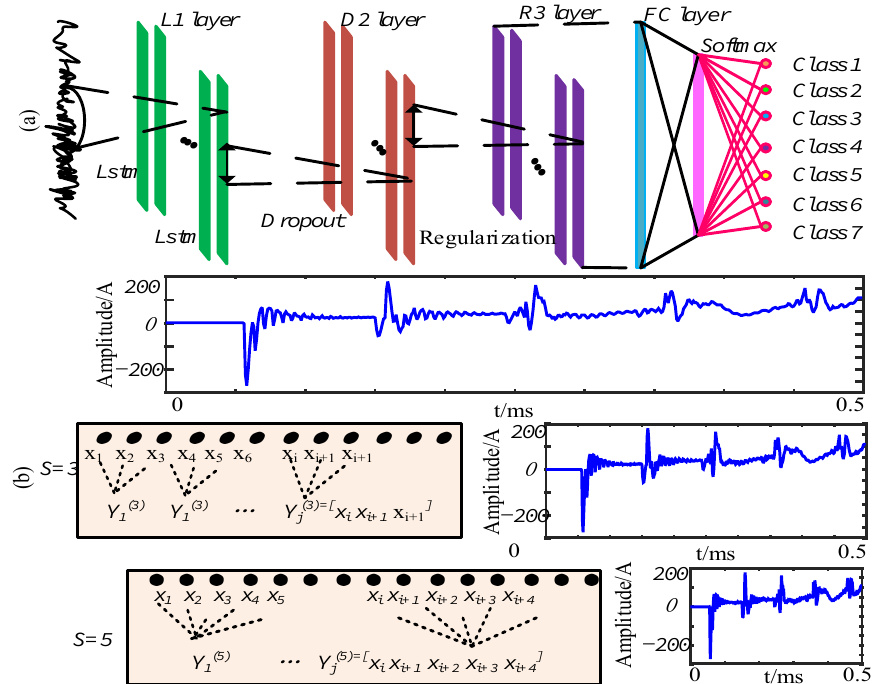
Figure 7. LSTM structure diagram ( a ) the LSTM network structure and ( b )the multi-scale 1D data transformation structure.